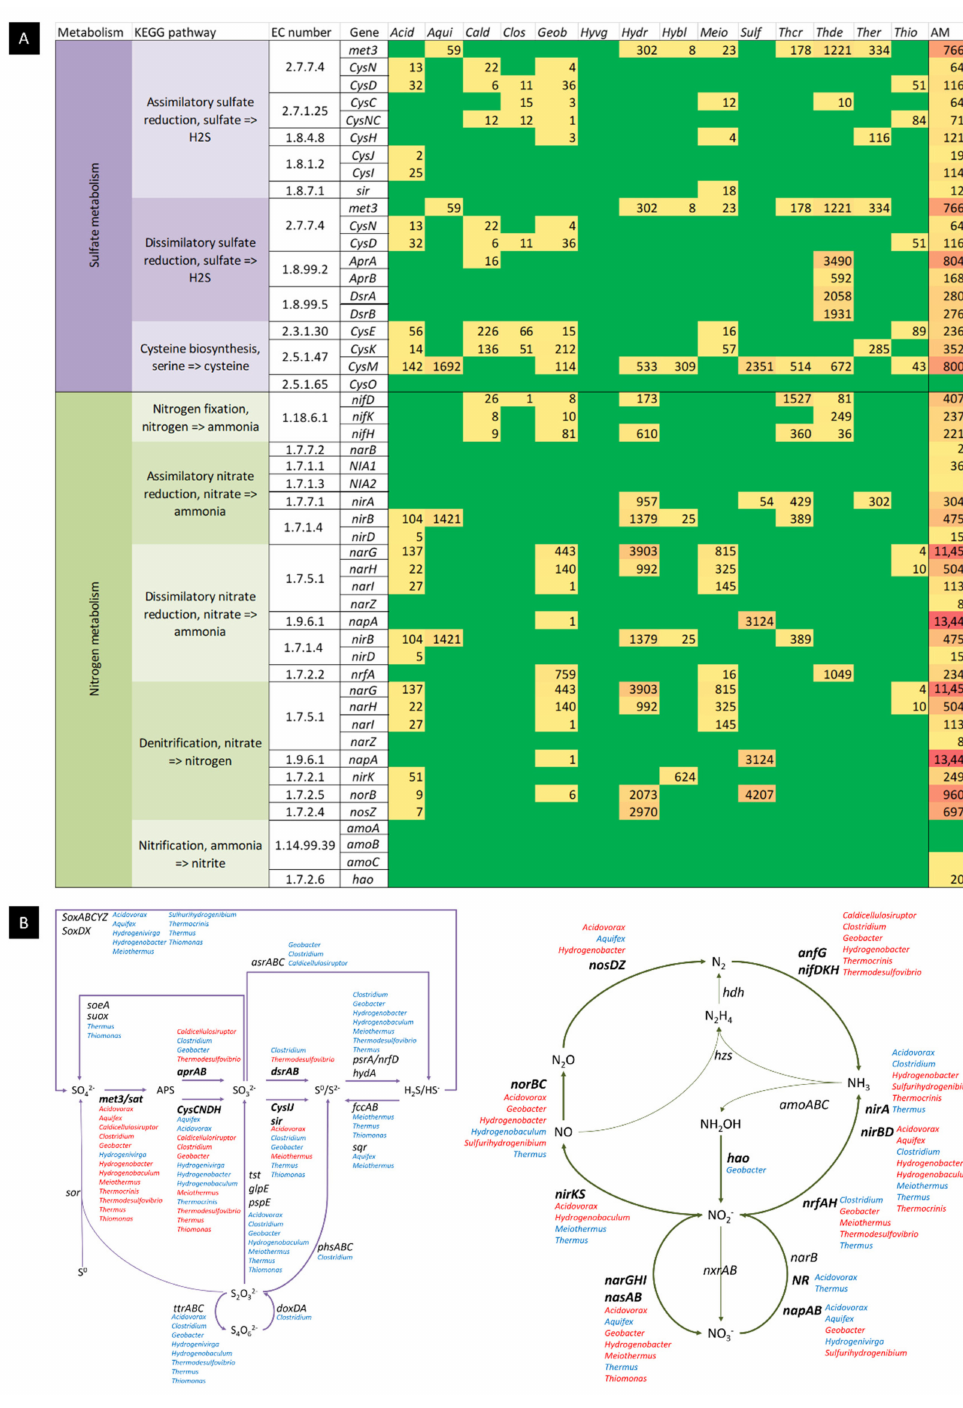
Figure 5. Metabolic assessment of the Muiño da Veiga metagenome in main genera of the microbial community. ( A ) The occurrence of genes in the metagenome from Muiño da Veiga involved in selected metabolic processes in main members of the microbial community as found by cross referencing KO and RefSeq databases. In green, genes that returned zero reads. In yellow to red gradient, the number of reads (in ascending order) that have a hit both KO and RefSeq databases. Acid : Acidovorax ; Aqui : Aquifex ; Cald : Caldicellulosiruptor ; Clos : Clostridium ; Geo : Geobacter ; Hyvg : Hydrogenivirga ; Hydr : Hydrogenobacter ; Hybl : Hydrogenobaculum ; Meio : Meiothermus ; Sulf : Sulfurihydrogenibium ; Thcr : Thermocrinis ; Thde : Thermodesulfovibrio ; Ther : Thermus ; Thio : Thiomonas ; AM: all reads across the metagenome. ( B ) Sulfur and nitrogen cycles in the Muiño da Veiga metagenome. Names in